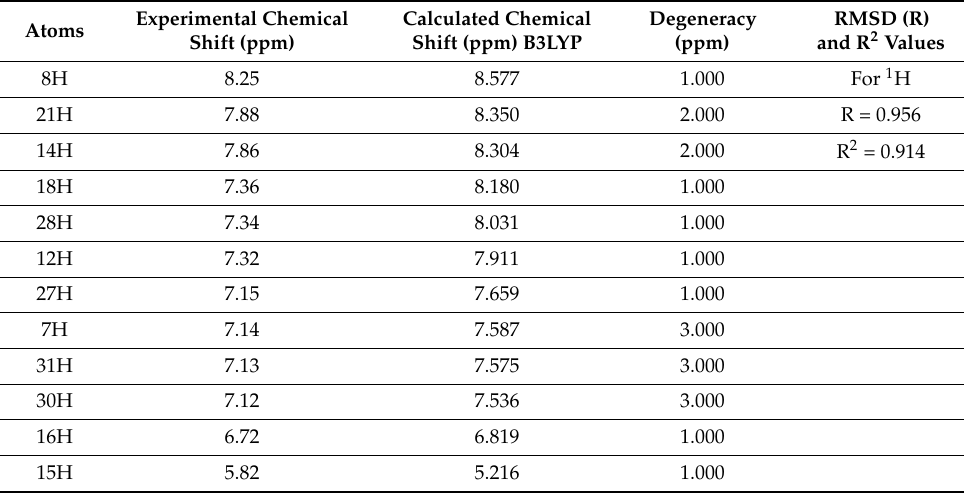
Table 6. Experimental and theoretical 1 H chemical shift values of 21HBMBA